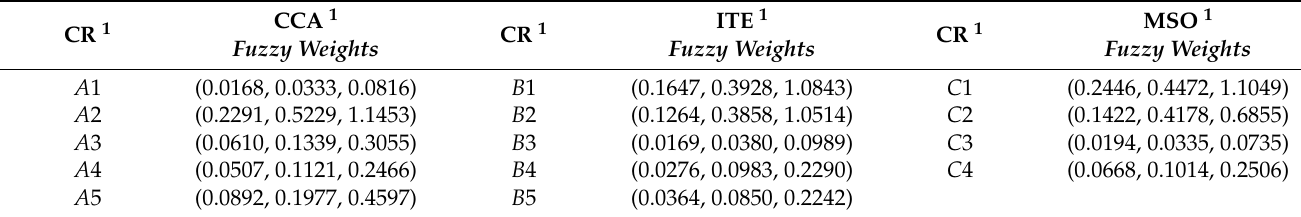
Table 3. The importance FAHP weights of the main criteria calculated after the experts made a pairwise